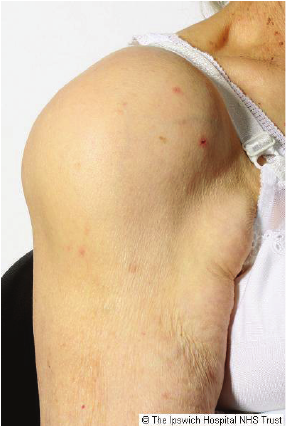
Figure 1: Submission remains copyrighted by the Ipswich Hospital NHS trust as per trust policy—we have permission from the patient and also from the trust to publish.